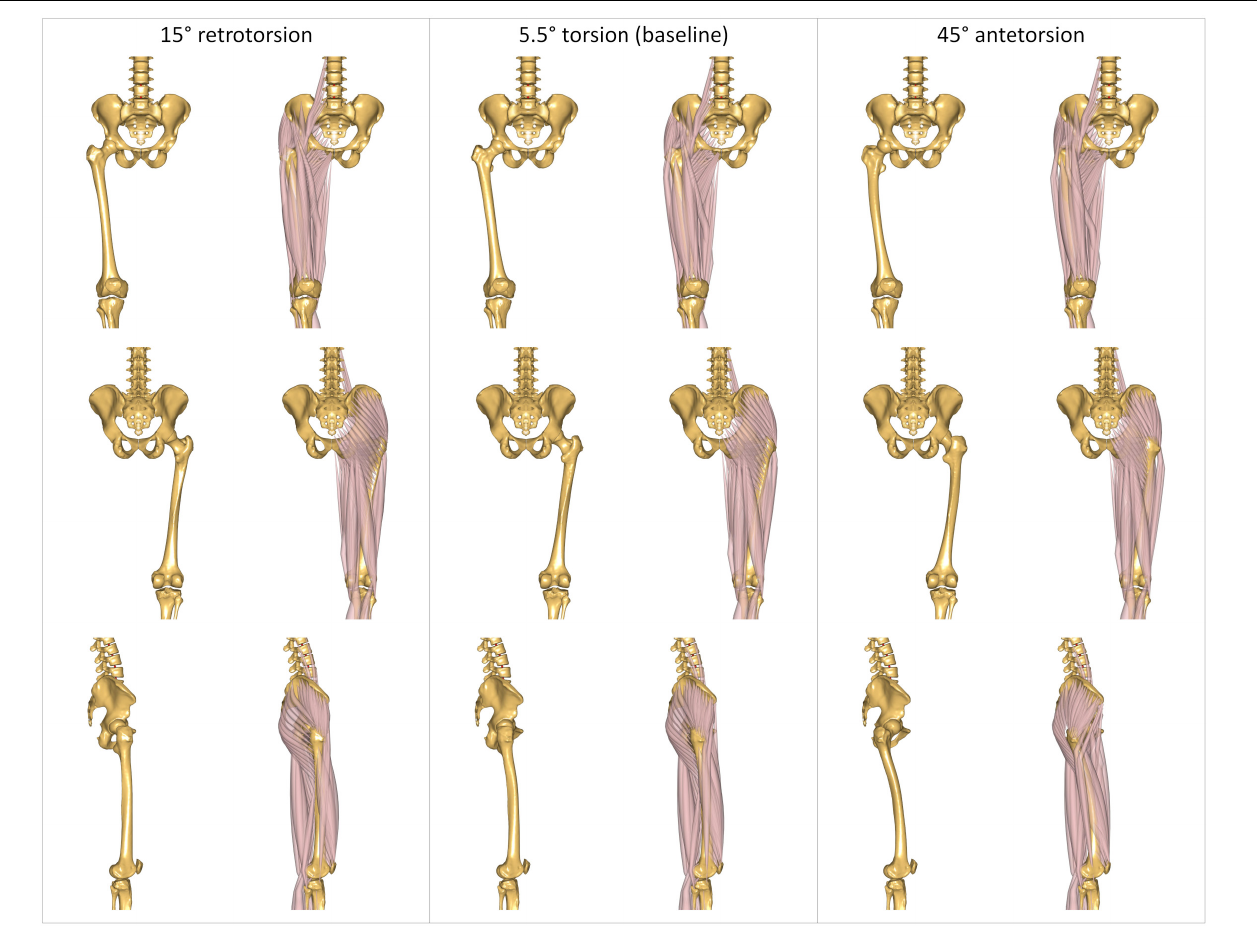
FIGURE 2 | Three representative modeled torsional configurations implemented in the AnyBody Modeling System. The femurs are characterized by 15 ◦ of retrotorsion (left); 5.5 ◦ of antetorsion (center), corresponding to the baseline unmorphed model; and 45 ◦ of antetorsion (right). Illustrations report anterior (top), posterior (middle), and lateral (bottom) views. Each view is reported without and with muscles, to better visualize the effect of the morphing on the bone geometry, and the resulting changes in the muscles’ lines of